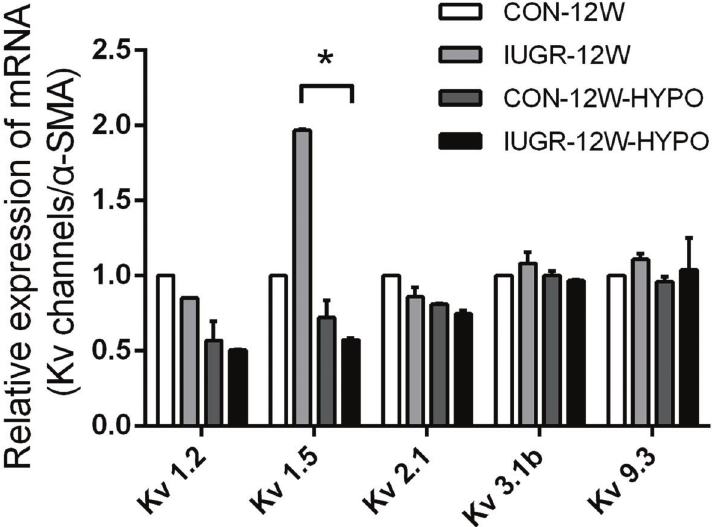
mRNA expression of Kv1.5 between control-hypoxia and IUGR-hypoxia groups (Figure 3).